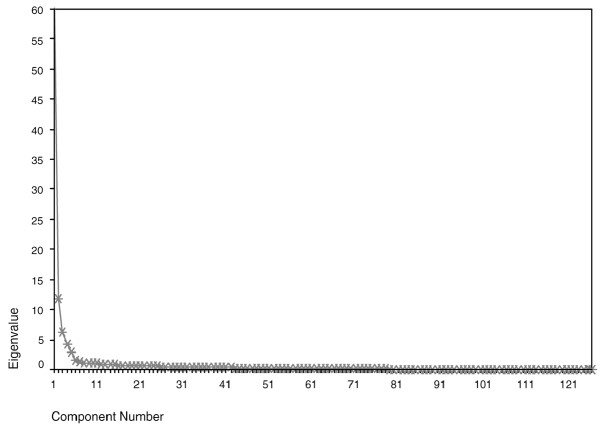
Scree plot. Example of a scree plot from the perpendicular profile. The first component typically accounts for the largest amount of variance. The components are chosen to the left of an 'elbow' in the plot. Here components 1 to 5 are included in the analysis as they lie before the 'elbow' at point6 (eigenvalue = 1.63).